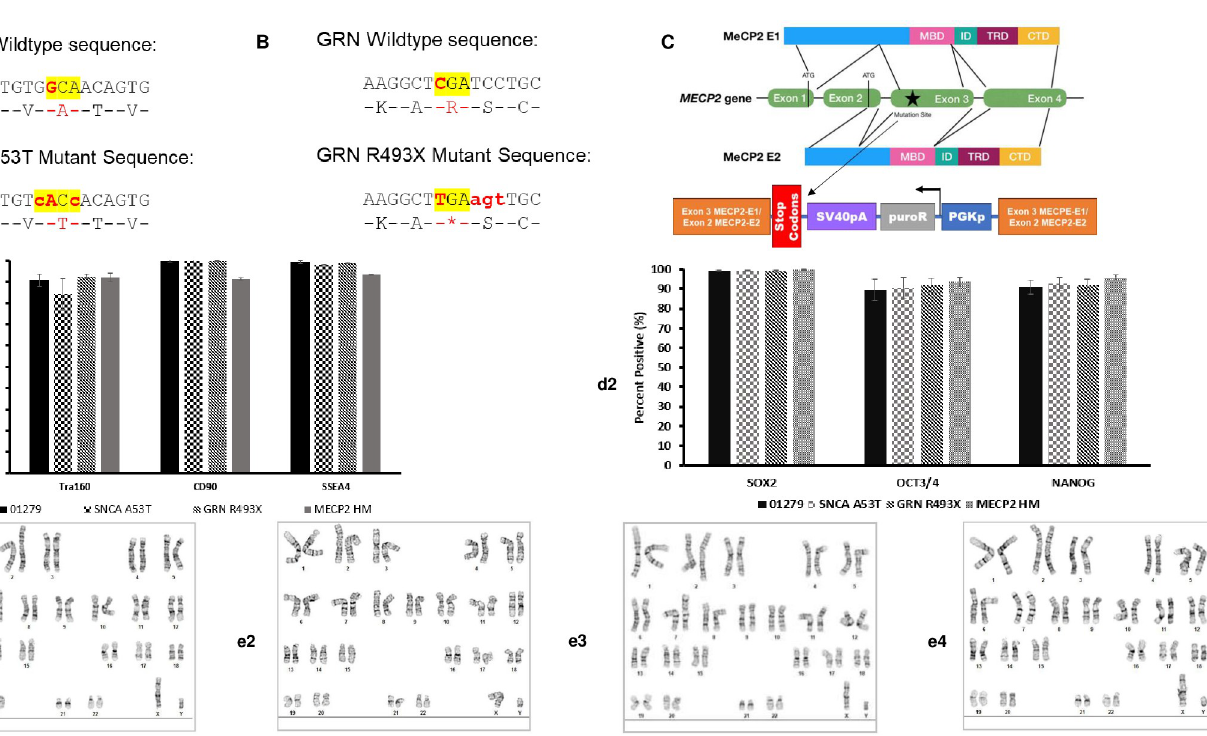
PLOS ONE | https://doi.org/10.1371/journal.pone.0250107 April 22,